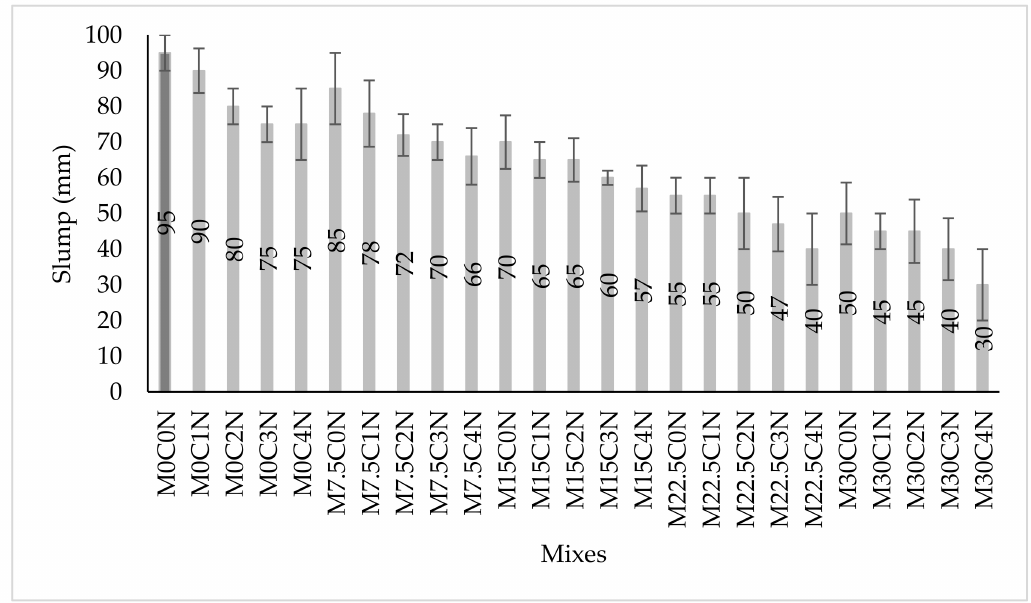
Figure 6. Slump Test